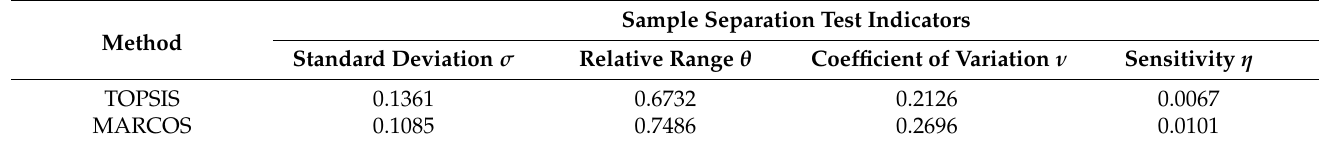
Table 12. The sample separation test indicators of the TOPSIS and MARCOS